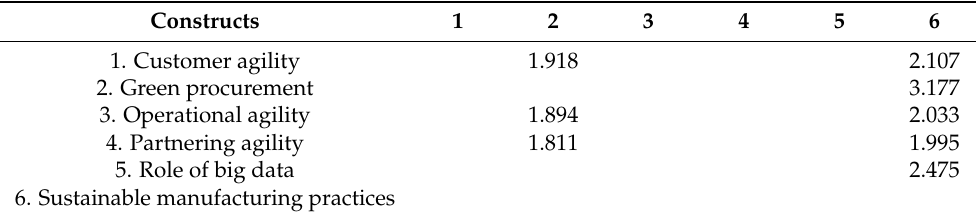
Table 3. Variance Influence Factor.